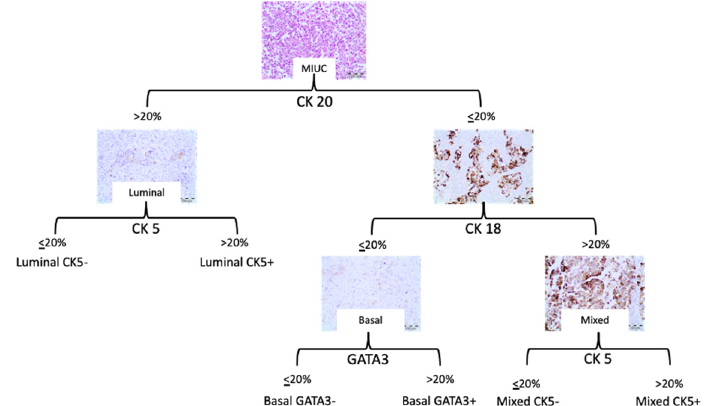
Figure 4. Proposed algorithm based on two markers and the representation of the bootstrap clustering results and heatmap analysis.